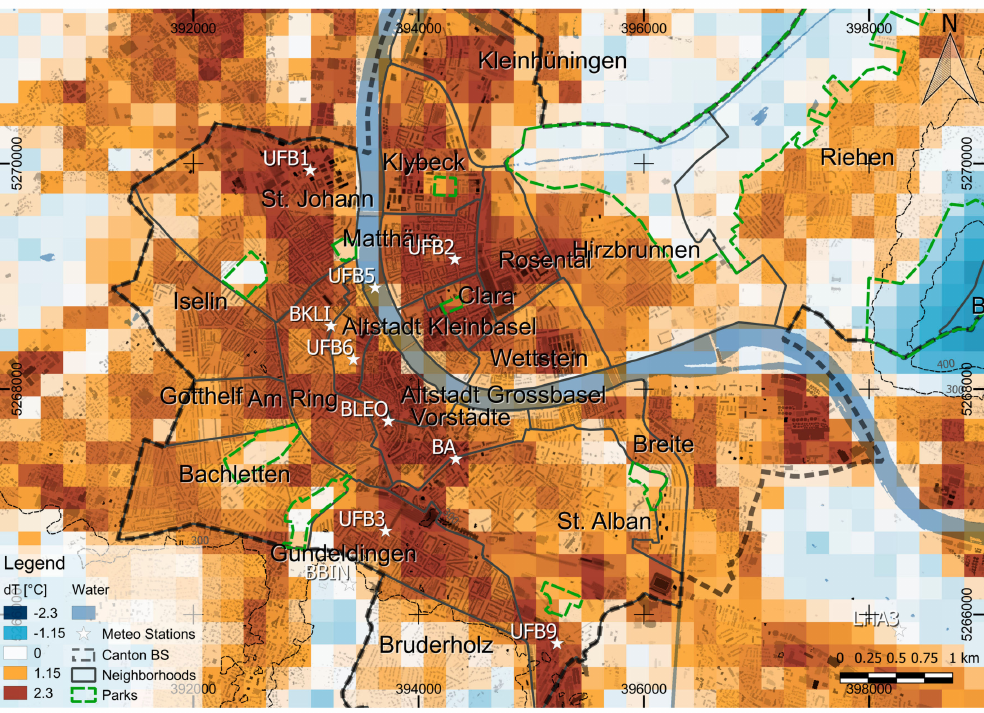
Figure 5. Zoom to the city center showing the difference between each grid point and the MeteoSwiss station Basel/Binningen (BBIN, lower left third of the map) based on the model output with 200 m grid size and the Land Cover predictors at 22:00 CET. The border of the Canton Basel-Stadt (BS) is shown as a dashed line and the buildings are plotted as a dimmed overlay. Large parks within BS are manually included as green polygons and the different neighborhoods are indicated as labelled dark grey polygons. The white stars are measurement stations used for the analysis. The river Rhine is shown as a transparent blue overlay and the coordinate system is